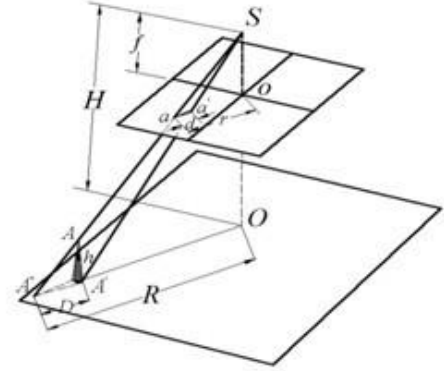
Figure 1. The image point displacement due to the surface height